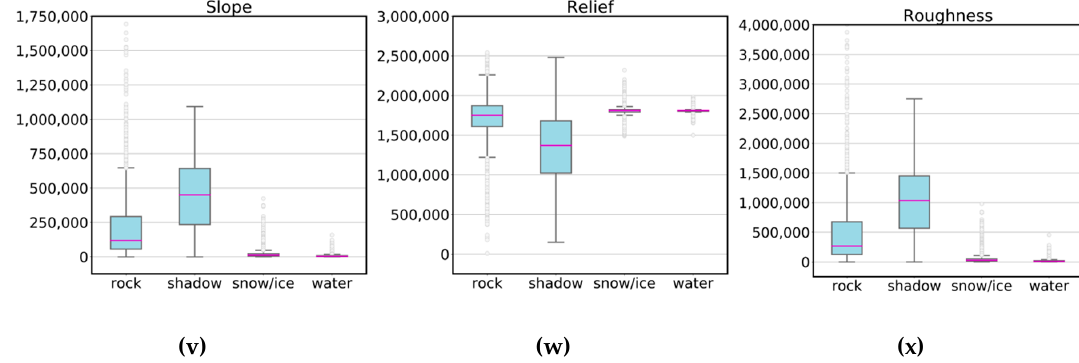
Figure 4. Distribution of pixel values according to their class membership. ( a ) B2: Blue reflectance. ( b ) B3: Green reflectance. ( c ) B4: Red reflectance. ( d ) B5: Red Edge 1. ( e ) B6: Red Edge 2. ( f ) B7: Red Edge 3. ( g ) B8: NIR. ( h ) B8A: Red Edge 4. ( i ) NDWI 1 . ( j ) NDWI 2 . ( k ) NWI. ( l ) AWEI sh . ( m ) AWEI nsh . ( n ) TC wet . ( o ) NDSI. ( p ) SWI. ( q ) NDGI. ( r ) SAVI. ( s ) SI. ( t ) NDI. ( u ) DEM. ( v ) Slope. ( w ) Relief. ( x ) Roughness. The boxplots show the interquartile ranges, the median, the range of the data as well as outliers. In ( a – h ), the y-axes show the Sentinel-2 surface reflectance values for each band and in ( i – t ) and ( u – x ), the y-axes represent normalized indices and scaled representations of the topographic layers respectively. Table 3. Sentinel-2 derived indices used for supraglacial lake detection with the Random Forest classifier. Feature Index